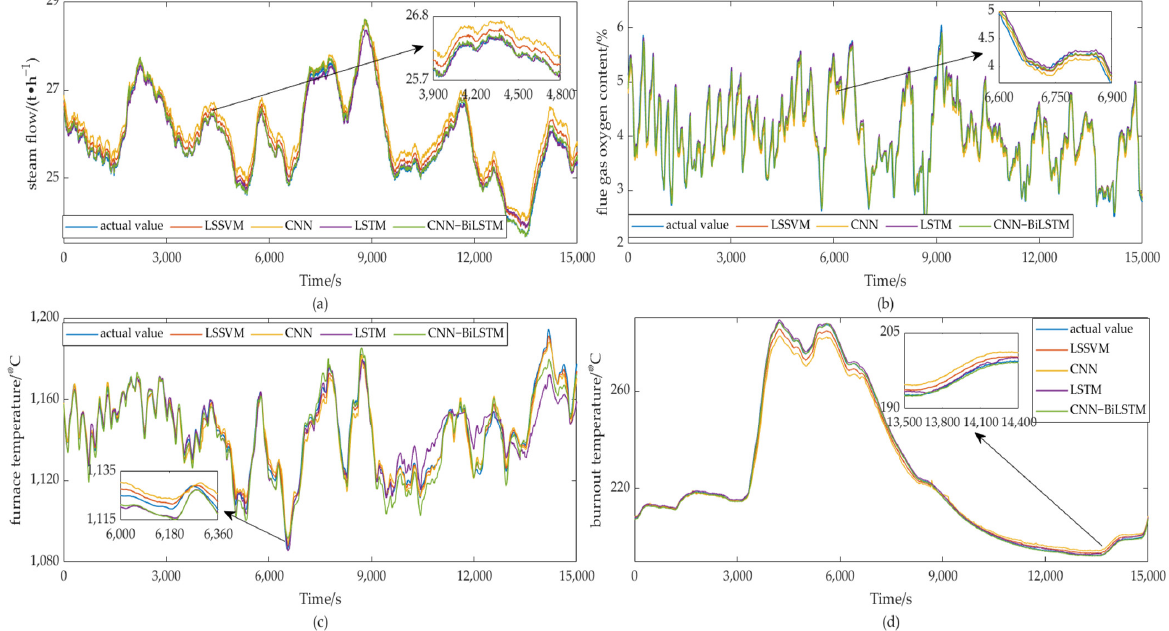
Figure 7. Modeling result diagram. ( a ) Comparison of output results of steam flow model; ( b ) comparison of the output results of the flue gas oxygen content model; ( c ) comparison of output results of the furnace temperature model; ( d ) comparison of the output results of the temperature model in the ember